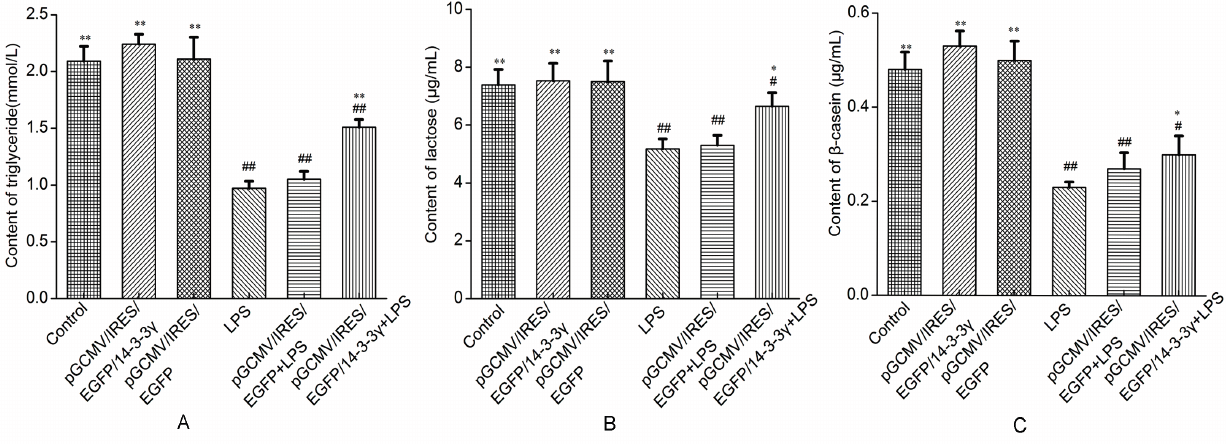
Figure 8. Effects of 14-3-3 γ overexpression on the secretion of β -casein, triglycerides and lactose in LPS-induced DCMECs. DCMECs were pre-transfected with pGCMV-IRES- EGFP-14-3-3 γ or pGCMV-IRES-EGFP for 24 h and then were treated with LPS (1 μ g/mL). After 36 h, the content of β -casein, triglycerides and lactose were determined using an assay kit. ( A ) Triglyceride content; ( B ) lactose content; ( C ) β -casein content. Bars indicate the mean ± SD ( n = 3). * p < 0.05 and ** p < 0.01 vs. LPS group; # p < 0.05 and ## p < 0.01 vs. control